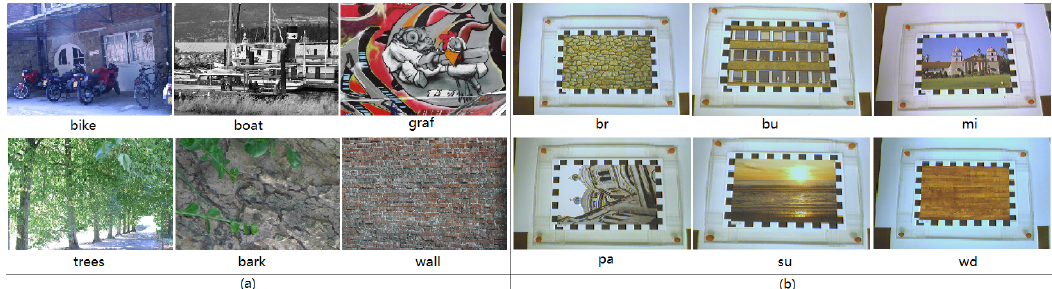
Figure 4. The datasets used in our experiments: ( a ) Wide baseline images set provided in the paper [22]; ( b ) Videos provided in the paper [5]. The videos are obtained through a controllable camera under situations of rotation, motion blur, lighting and so on. Both the two datasets, including all necessary material, are declared to be publicly available online and the download urls can be found in their